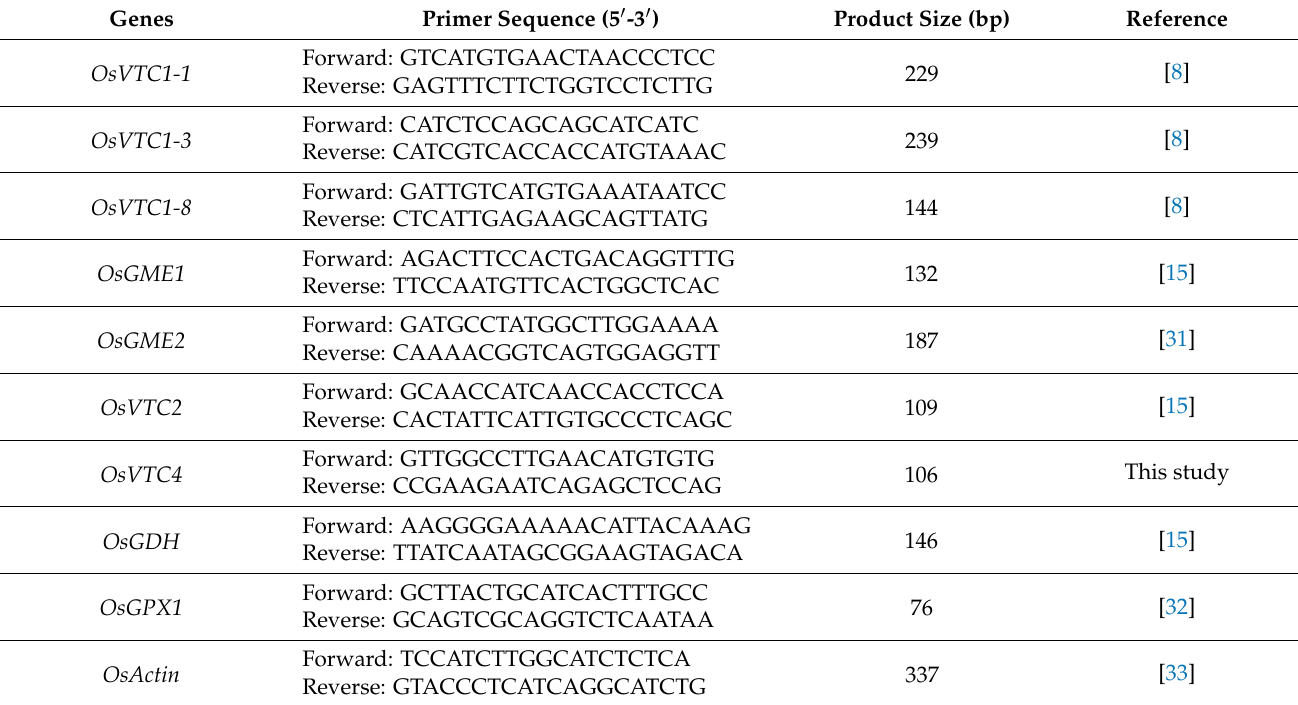
Table 1. Primer sequences used for qPCR